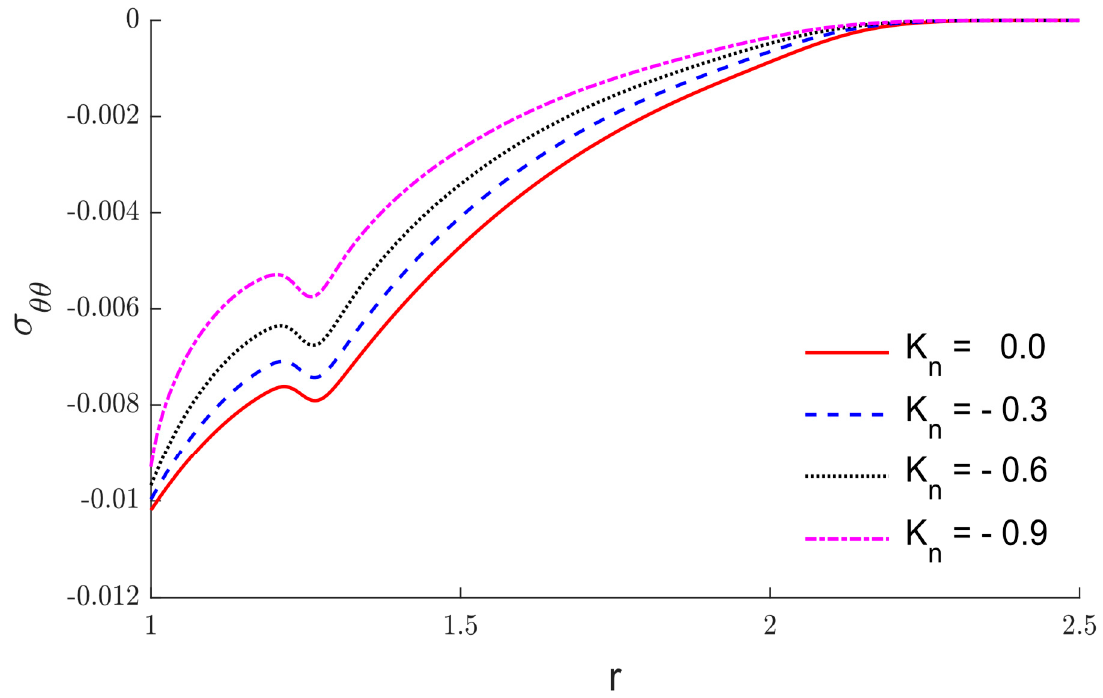
Figure 4. The variations of radial stress σ rr via r when τ o = 0.05 under varying thermal conductivity.